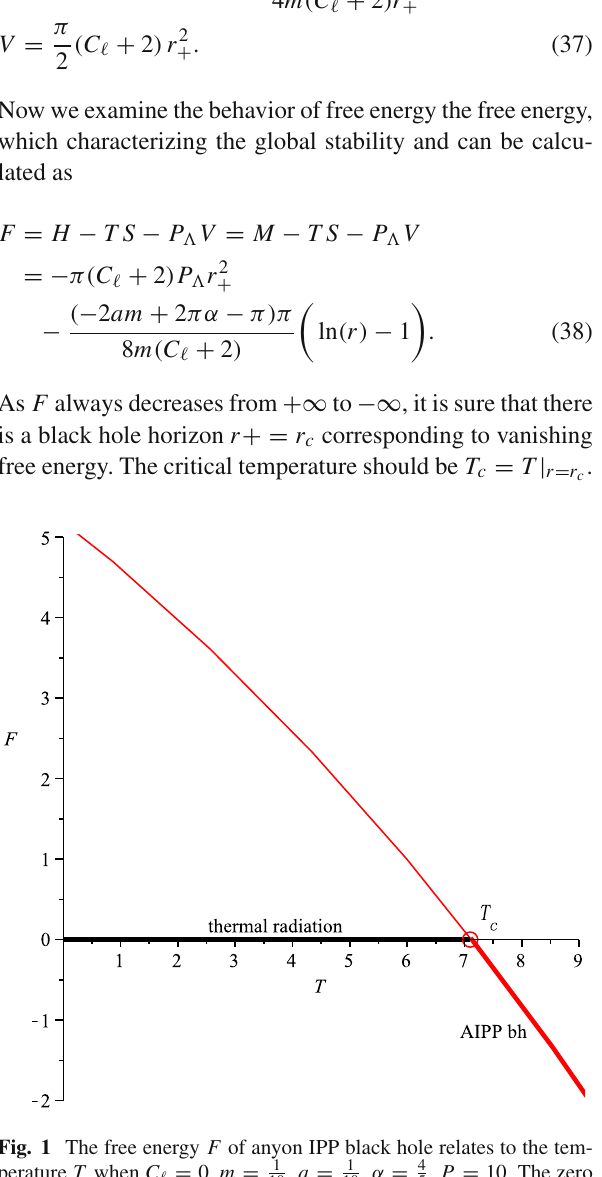
, a = 1 ,α = 4 , P = 10. The zero 10 10 5